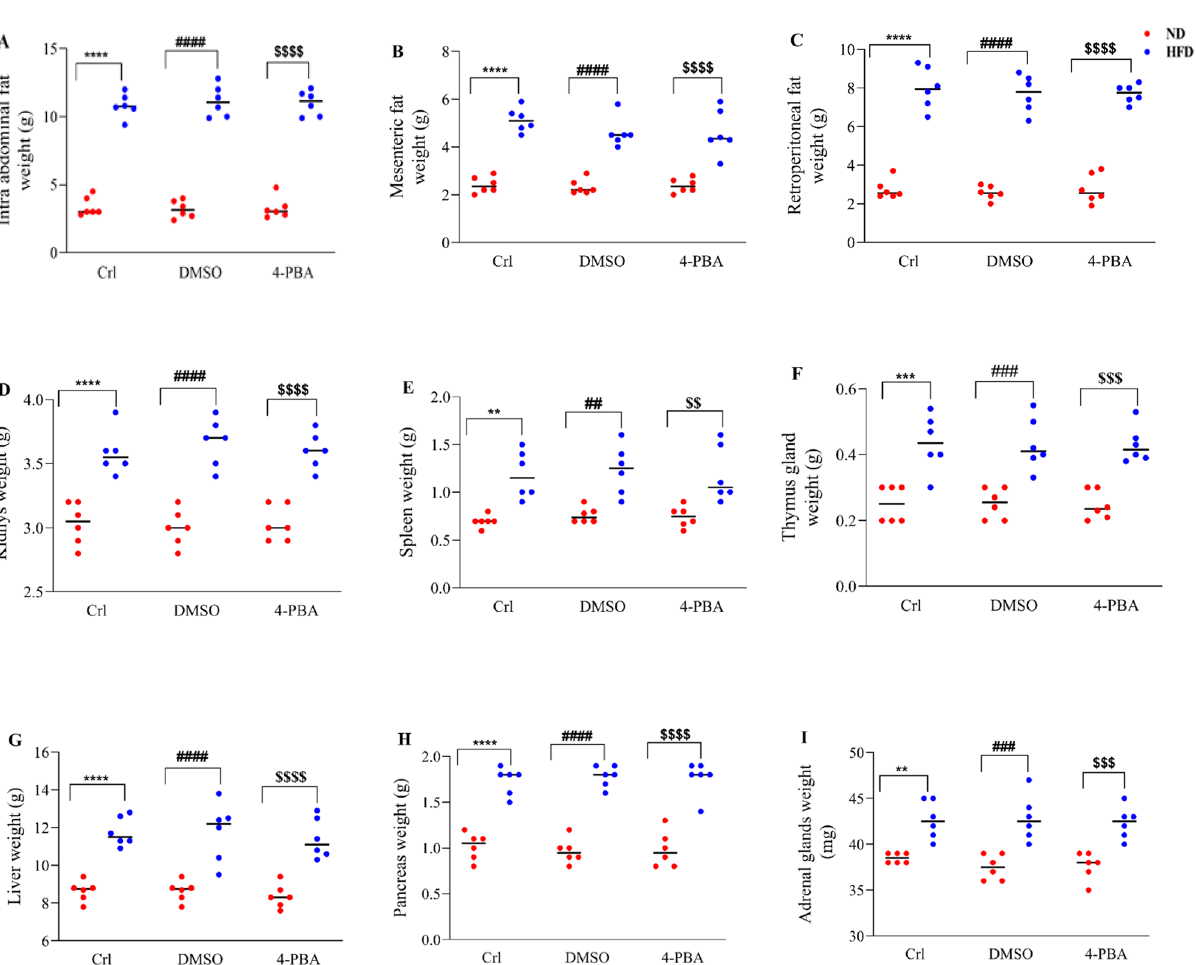
Figure 9. Effect of high-fat diet and/or 4-PBA on the weight of ( A ) intraabdominal, ( B ) mesenteric and ( C ) retroperitoneal fats, and ( D ) kidneys, ( E ) spleen, ( F ) thymus gland, ( G ) liver, ( H ) pancreas and ( I ) adrenal glands. Each point represents the mean ± SEM (6 rats/group). **p < 0.01, ***p < 0.001, ****p < 0.0001, versus control of ND group, ## p < 0.01, ### p < 0.001, #### p < 0.0001 versus ND + DMSO group, $$ p < 0.01, $$$ p < 0.001, $$$$ p < 0.0001 versus ND + 4-PBA. ND Normal diet, HFD High-fat diet, Crl Control, DMSO Dimethyl Sulphoxide, 4-PBA 4-Phenyl Butyric